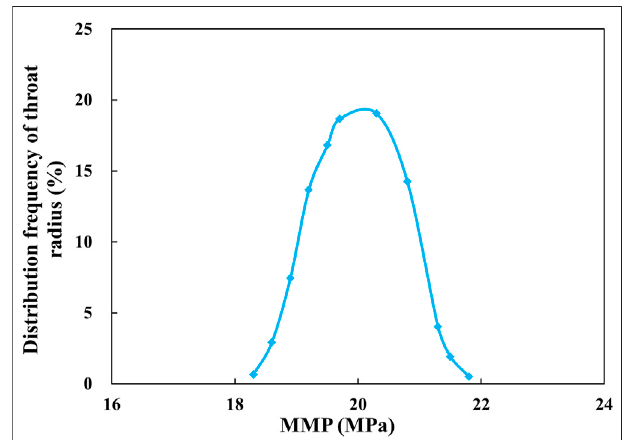
FIGURE 6 | Minimum miscible pressure distribution diagram.